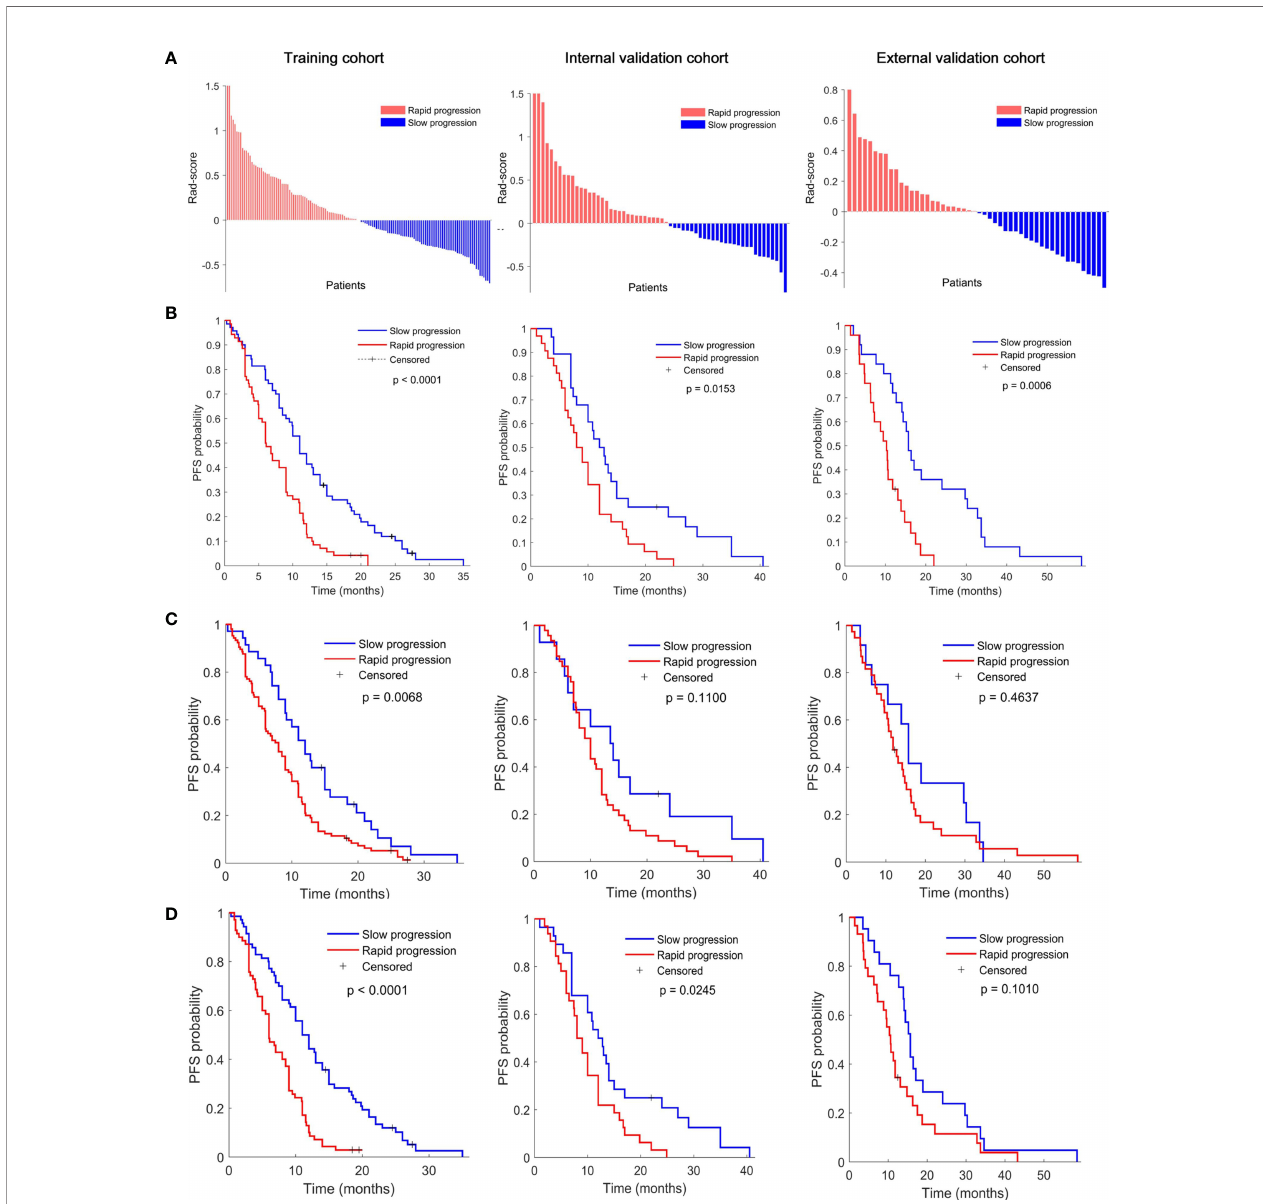
FIGURE 2 | (A) Rad-score according to the three-feature signature and Kaplan – Meier survival curves of (B) radiomics model, (C) clinical model, and (D) combined model in the training (left), interval validation (middle), and external validation cohorts (right). All scores have subtracted the cutoff. P values were calculated using the log-rank